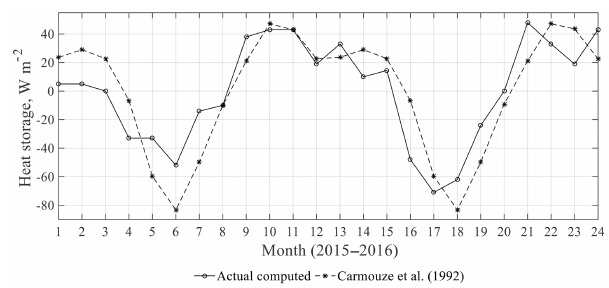
Figure 5. Change of heat storage in